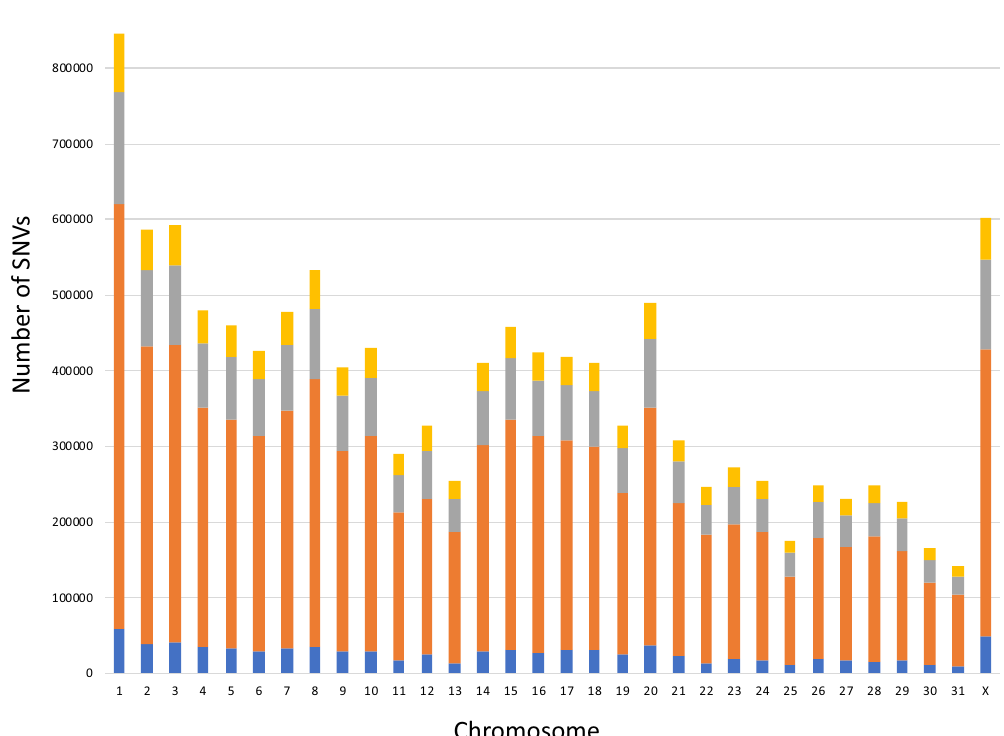
Figure 1. Distribution of single-nucleotide variants (SNVs) detected in 101 Thoroughbred horses. Blue: A to T or T to A; orange: A to G (T to C) or G to A (C to T); grey: A to C (T to G) or C to A (G to T); yellow: G to C or C to